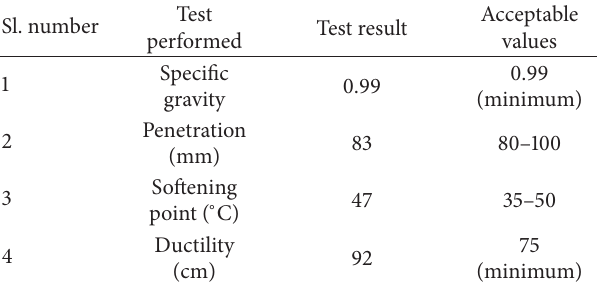
Table 1: Properties of